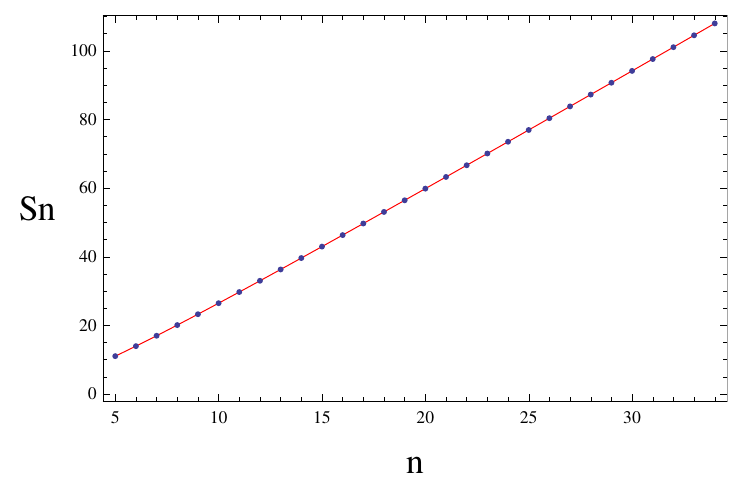
Figure 16 . The entanglement entropy of gauge (cid:12)eld with trivial center with degree of freedoms removed.